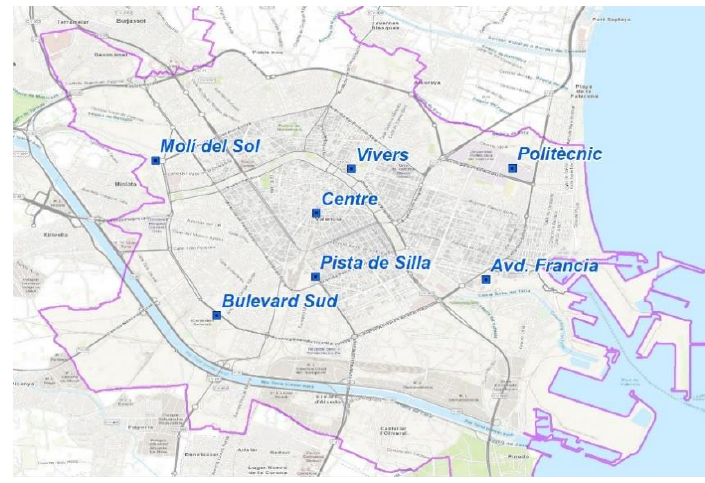
Figure 1. Map of air monitoring stations included in the study.